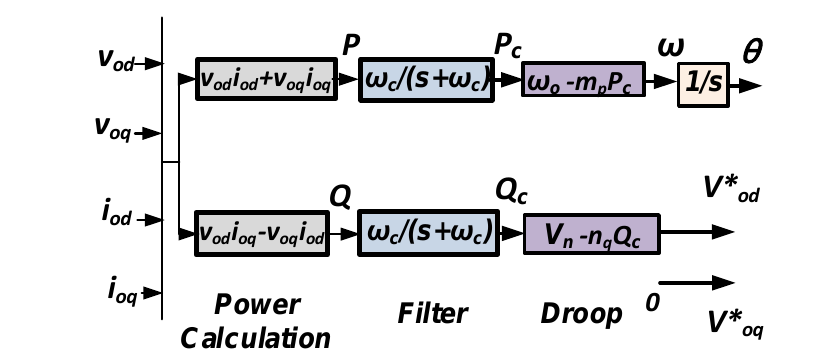
Figure 2. Power droop controller.